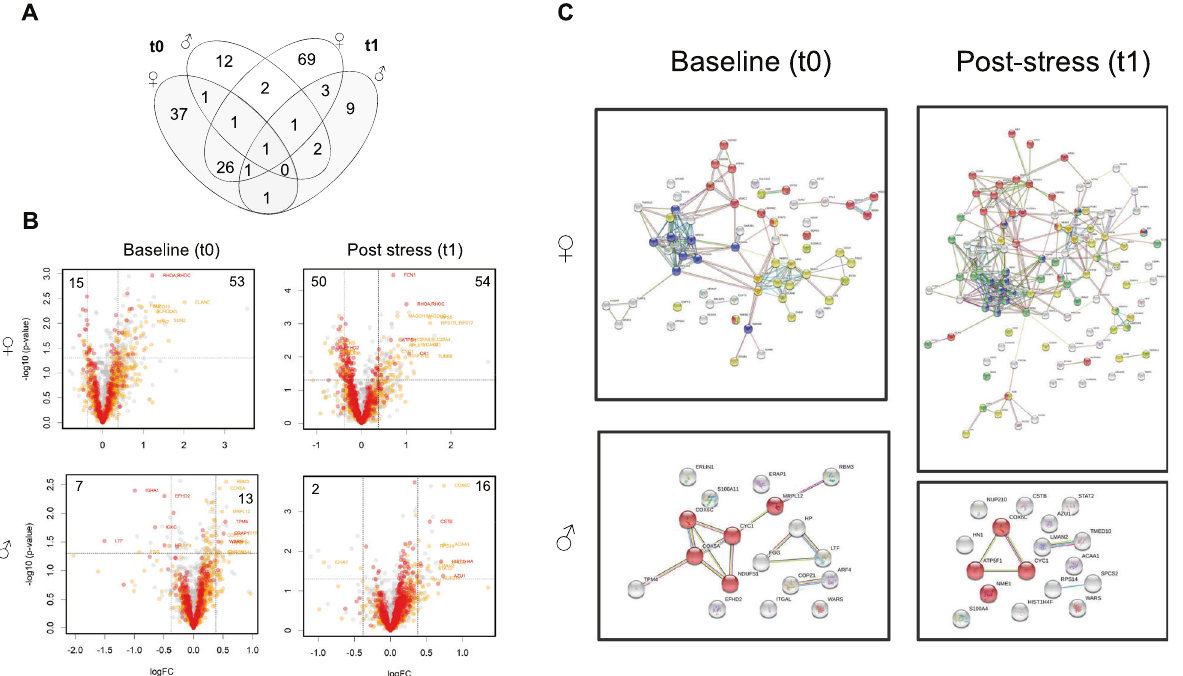
Fig. 3 Sex speci fi c protein expression differences before and after stress exposure. Across all groups compared, the largest overlap in differentially expressed proteins became evident in female participants ( A ). Depicting the underlying analysis, volcano plots show the extent of log 2 fold-changes (adversity vs. control) and -log 10 p value for protein levels at the t0 baseline measurement ( n prot = 1129) and at the t1 post-stress measurement ( n prot = 1206) for female ( n = 40) and male ( n = 19) participants. Please note that the imbalanced sex distribution might account to some extent for these effects. Dashed lines show the |1.3| FC cutoff criteria (vertical) and the 0.05 signi fi cance level (horizontal). Signi fi cantly up- (right quarter) or downregulated (left quarter) proteins are indicated by numbers. Please note that p values did not survive correction for multiple testing. Colors in volcano plots re fl ect the 80% (yellow) or 100% (red) validity threshold. Proteins colored in grey did not meet the 80% validity threshold and represent all other proteins ( B ). String networks were generated from proteins differentially expressed in male and female participants with a history of childhood adversity at t0 and t1. Colors indicate the biological function or cellular location. Blue proteins function in protein biosynthesis, red proteins map to mitochondria as a cellular component, yellow proteins play a role in the immune system relevant processes, and green proteins are associated with protein localization processes ( C